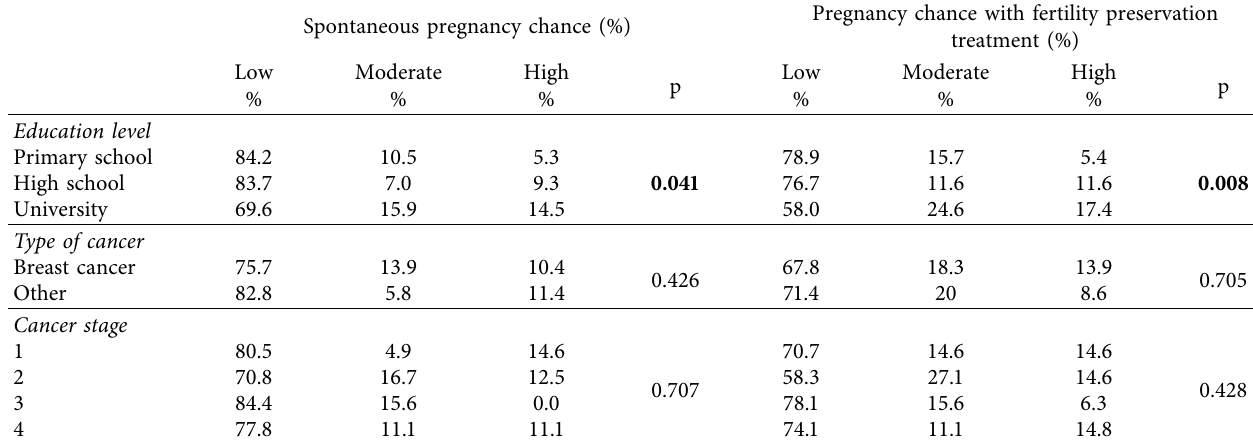
Table 3: Cancer stage, type, and education level according to the chance of a future pregnancy via spontaneously or fertility preservation